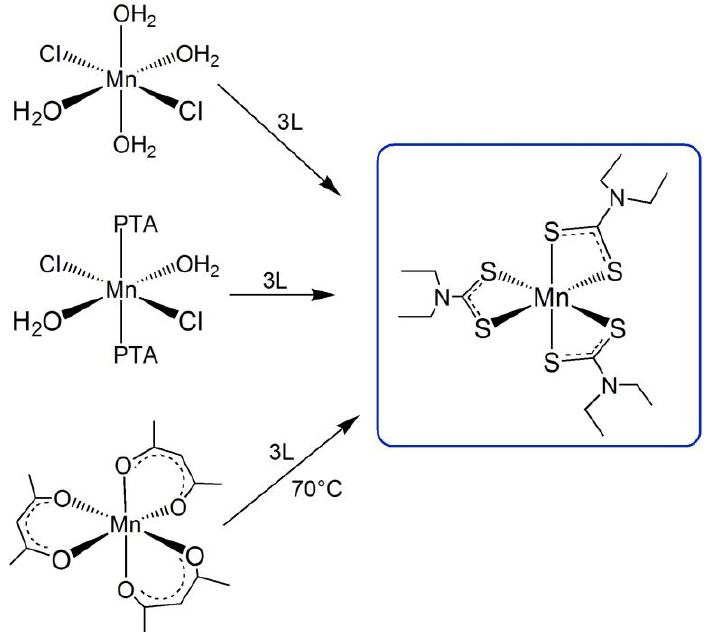
Figure 3. Scheme of the different routes investigated for the formation of the [MnL 3 ] ( 3 )